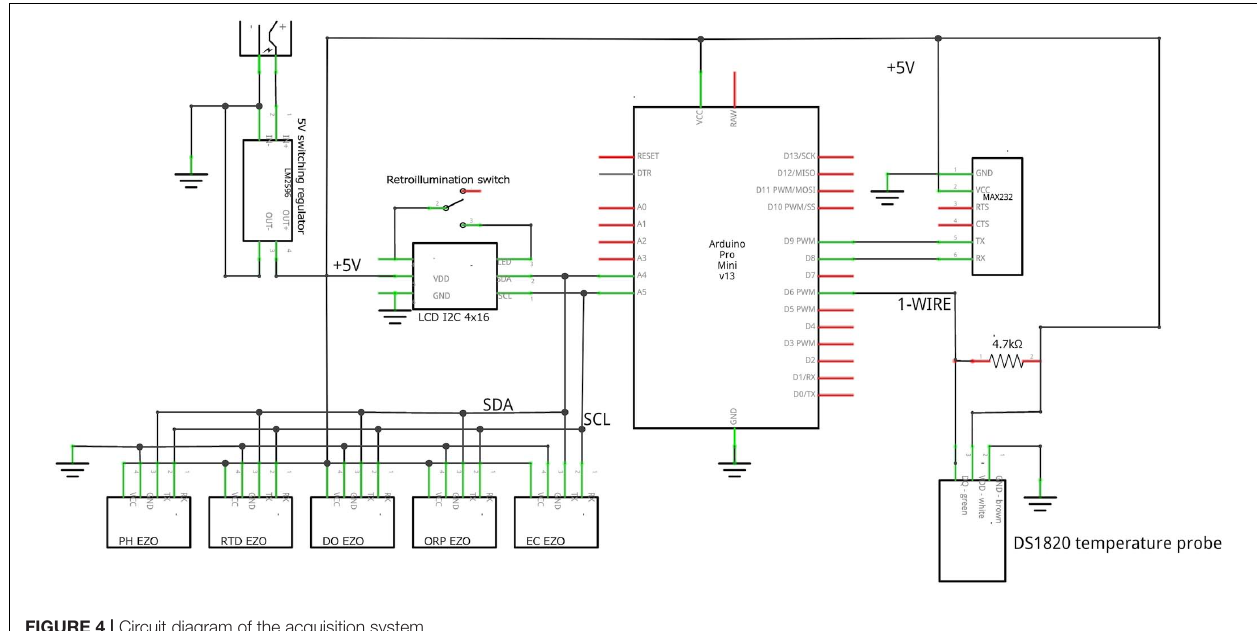
FIGURE 4 | Circuit diagram of the acquisition system.